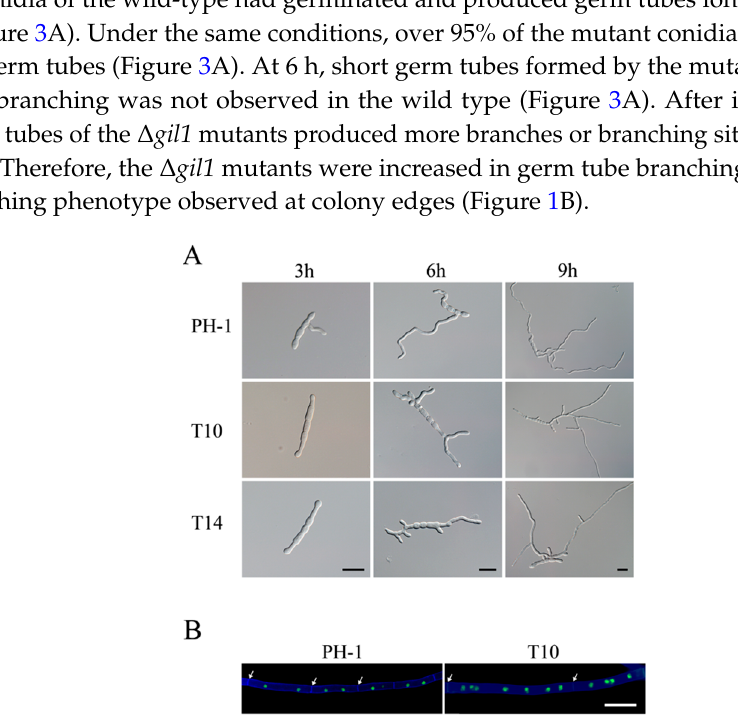
Figure 3. Defects in conidium germination and cytokinesisin the Δ gil1 mutants. ( A ) Conidia of the wild type (PH-1) and Δ gil1 mutants (T10 and T14) were incubated for 3, 6, and 9 h in YEPD medium. Bar = 20 µm; and ( B ) Vegetative hyphae from transformants of PH-1 and the Δ gil1 mutant T10 expressing the H1-GFP construct were stained with Calcofluor white (CFW) and examined by the epifluorescence microscopy. Septa are marked with arrows. Bar = 10 µm.